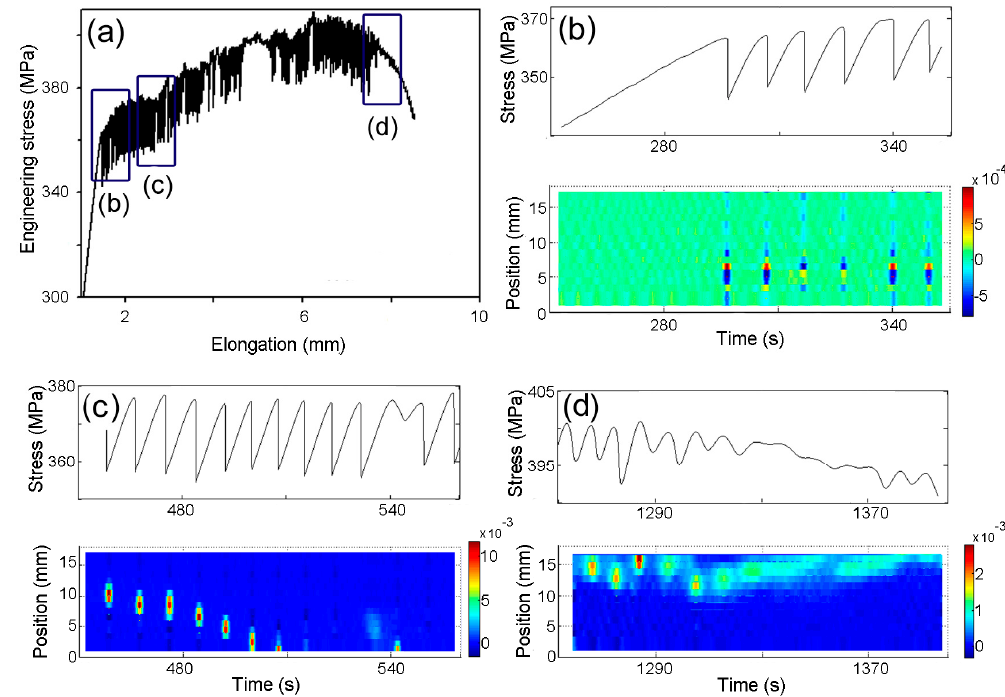
Figure 7. ( a ) Deformation curve recorded at 1.4 × 10 − 4 s − 1 for the alloy after 12 ECAP passes; ( b – d ) the corresponding strain-rate maps for the strain intervals denoted by rectangles in plot ( a ).